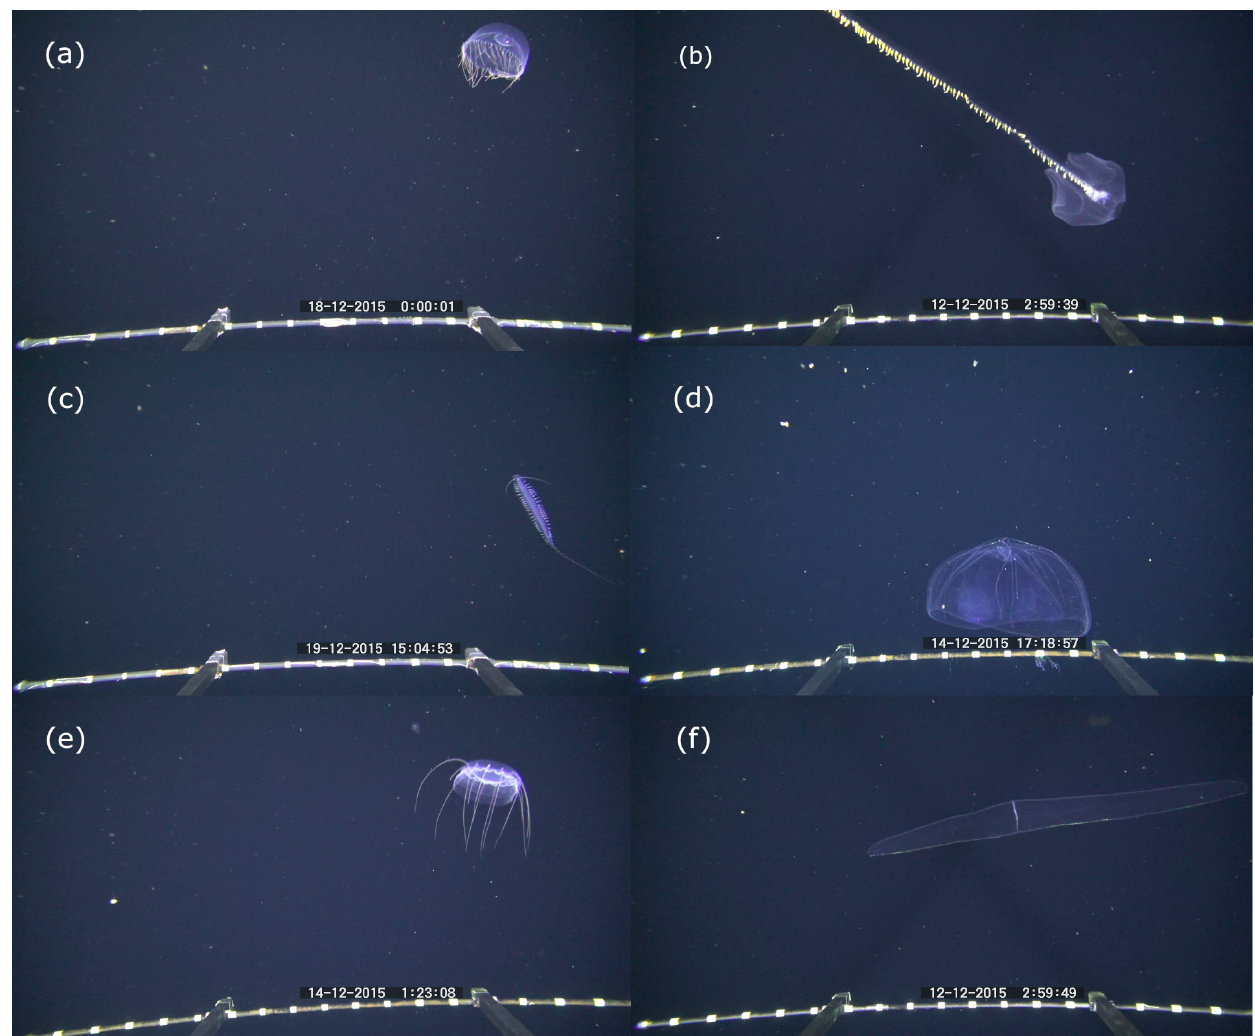
Figure 5. Examples of organisms encountered during pelagic video transects with PELAGIOS during cruise MSM49 in the eastern tropical Atlantic. (a) A medusa Halitrephes sp. (b) A siphonophore Praya dubia . (c) A tomopterid worm. (d) The ctenophore Thalassocalyce inconstans . (e) The medusa Solmissus . (f) The ctenophore Cestum . The distance between the white bands on the horizontal bar on the bottom of the images is